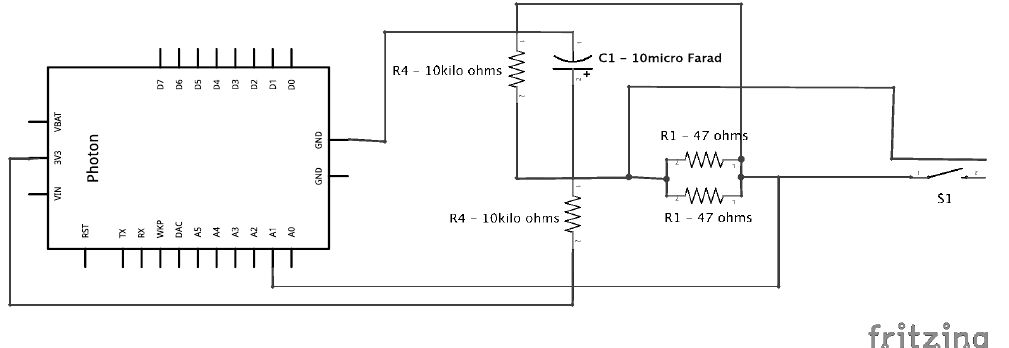
Figure 1. Schematic diagram of the proposed EECMS device using fritzing software.